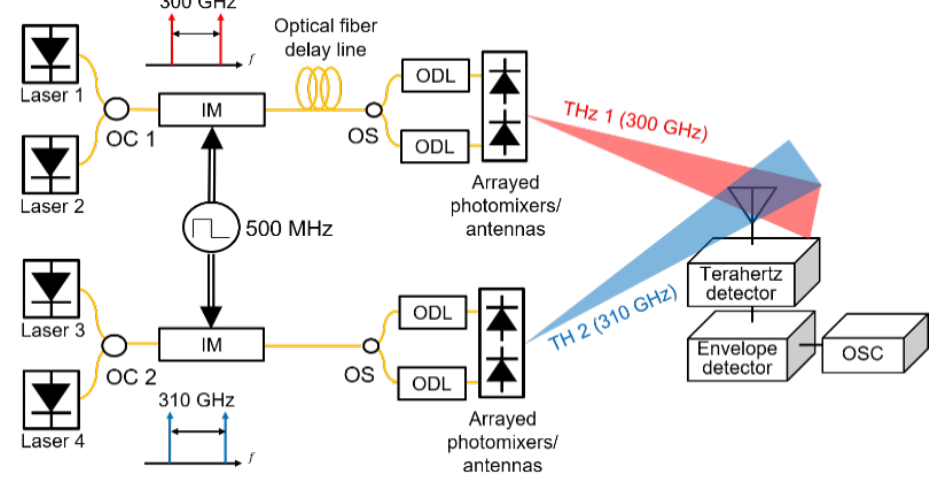
Figure 12. Experimental configuration for feasibility demonstration of the secured wireless commu- nication system.